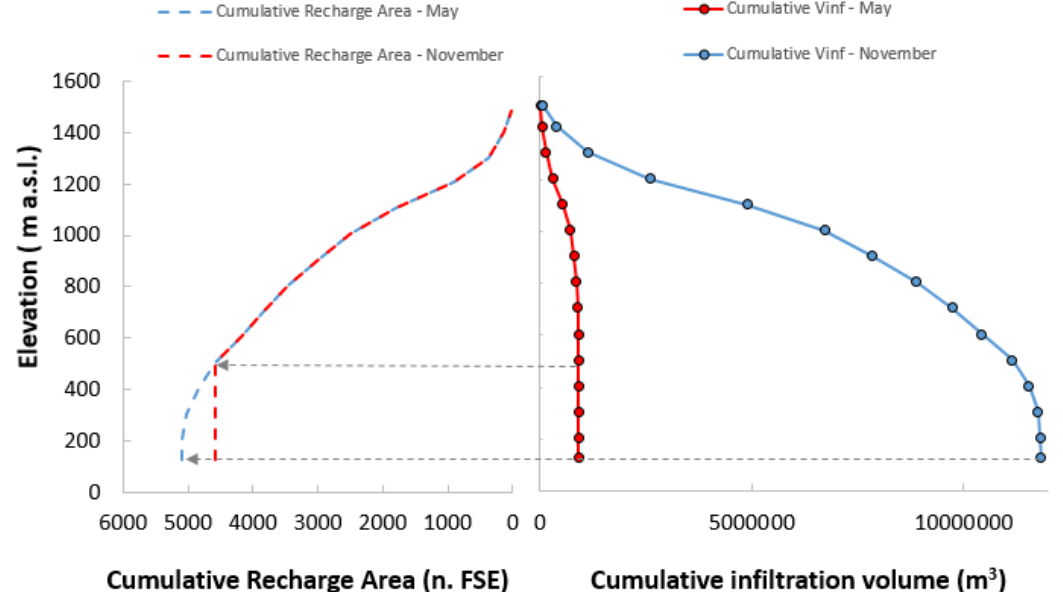
Figure 16. Cumulative recharge area of May and November on elevation (left); cumulative infiltration volume of May and November on elevation (right).